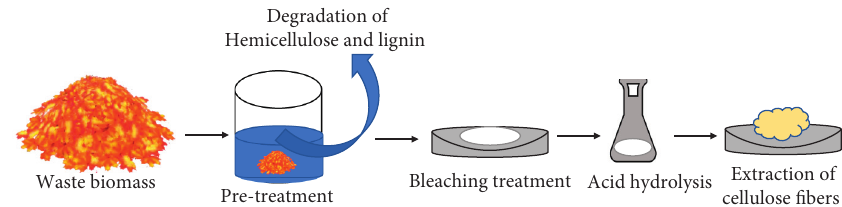
Figure 3: Illustration about methods of extraction of cellulose fiber from